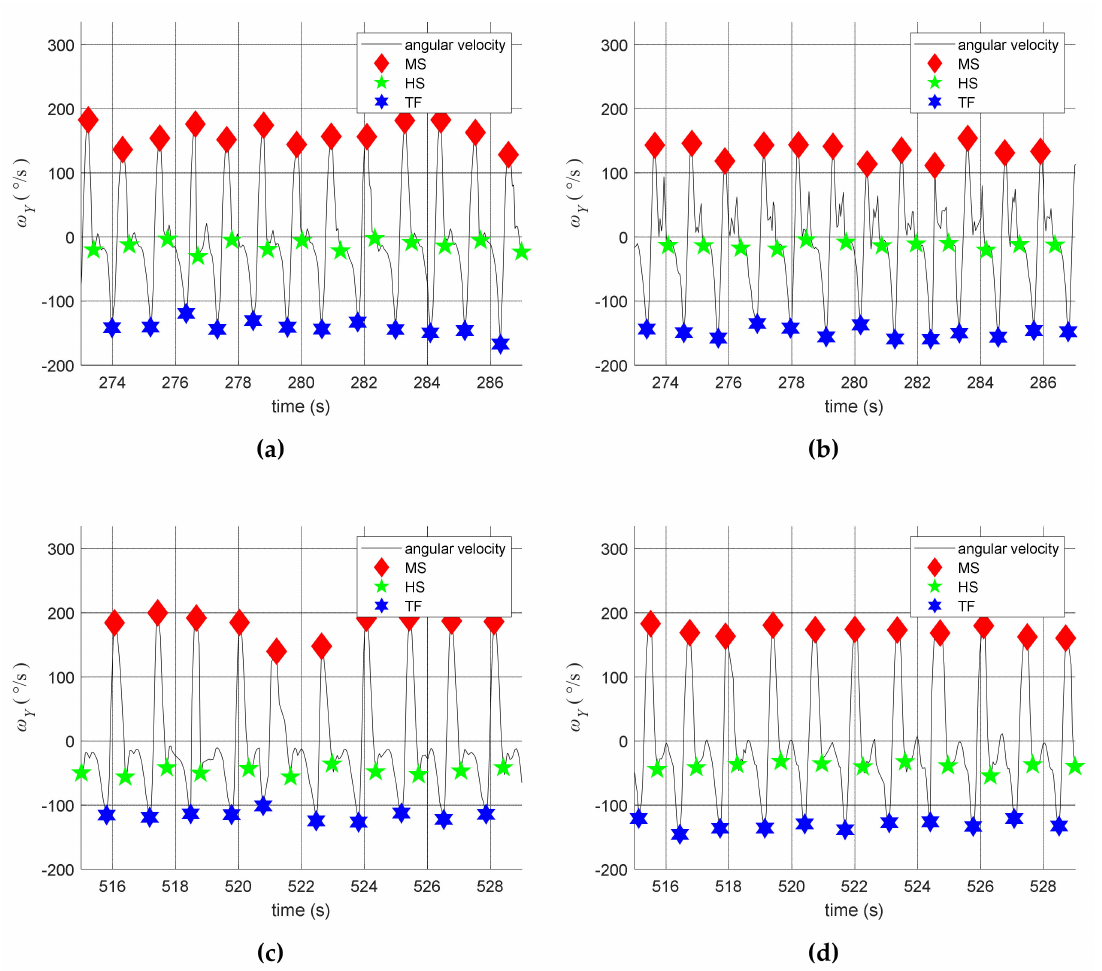
Figure 8. The detected gait events. ( a ) On the healthy leg of P1; ( b ) on the paretic leg of P1; ( c ) on the healthy leg of P2; ( d ) on the paretic leg of